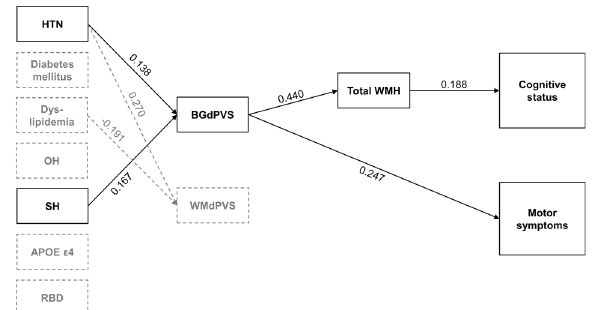
Fig. 1 Schematic diagram of path analyses for cognitive status and motor symptoms. Vascular risk factors (hypertension, diabetes mellitus, and dyslipidemia), autonomic risk factors (OH, SH), RBD, and APOE ε 4 status were entered as predictors. BGdPVS, WMdPVS, and total WMH were entered as mediators. Age, sex, years of education, disease duration, levodopa-equivalent dosage, CCSIT score, and the presence of depression were entered as covariates. Numbers on the paths are the standardized coef fi cients that were statistically signi fi cant. Abbreviations: BG basal ganglia, dPVS dilated perivascular spaces, CCSIT Cross-Cultural Smell Identi fi cation Test, HTN hypertension, OH orthostatic hypotension, RBD REM sleep- behavior disorder, SH supine hypertension, WM white-matter, WMH white matter